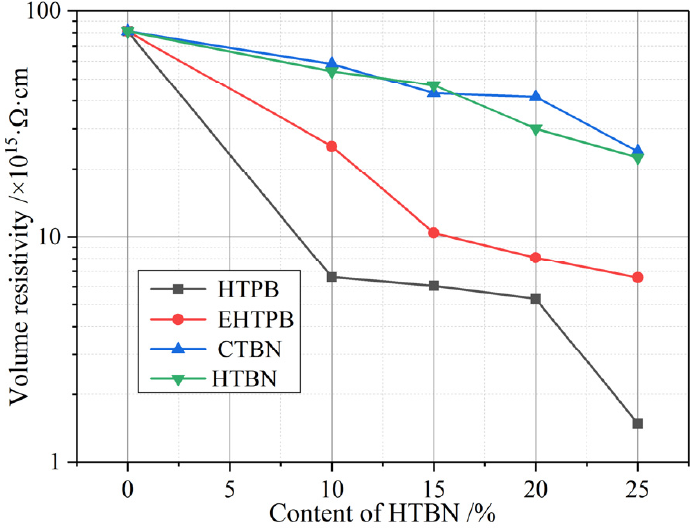
Figure 4. The volume resistivity of epoxy resin matrix varies with the content of liquid rubber. The volume resistivity decreases with the increase of liquid rubber content.